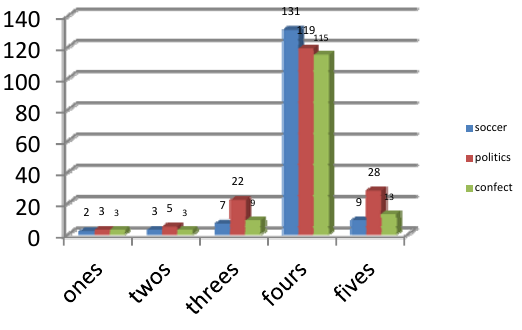
Fig. 1. Comparison of category